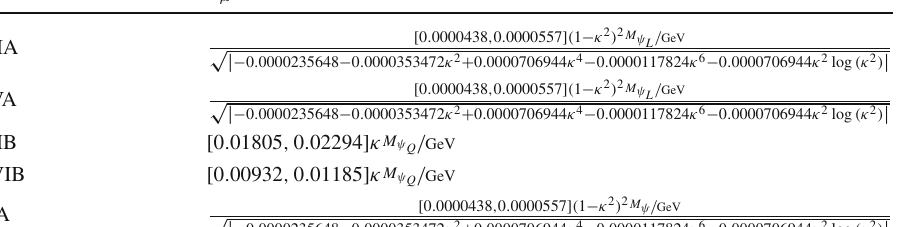
Table 7 Presented here are the constraints on new Yukawa coupling Γ μ for a solution of ( g − 2 ) μ . These constraints contain upper and lower bound on Γ μ formulated as an interval